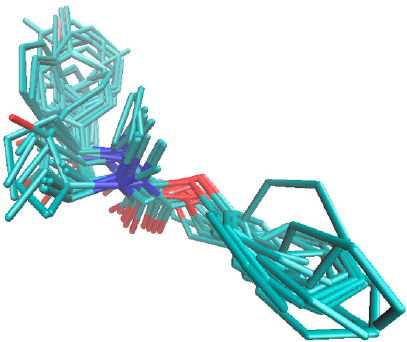
Figure 6. Comparison of the poses for the most active BChE inhibitors in the enzyme active site AC2. As an additional experiment galanthamine (GLT), which is a very active AChE/BChE inhibitor (IC 50 < 3 µ M) was docked in the enzyme active site AC2. Although the structural variations between GLT and RIV and the most active molecules are easily noticeable, similar spatial patterns of the host–BChE complex within the catalytic core was observed for the negatively charged atoms (nitrogen and oxygen), as presented in Figure 7.